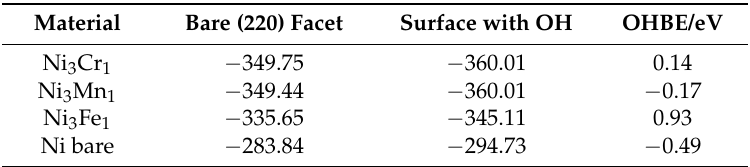
Table A6. Ground state energies of bare and with OH at (220) facet (1/8 ML) supercell 2 × 2 × 1 and calculated OHBE (all energies are in